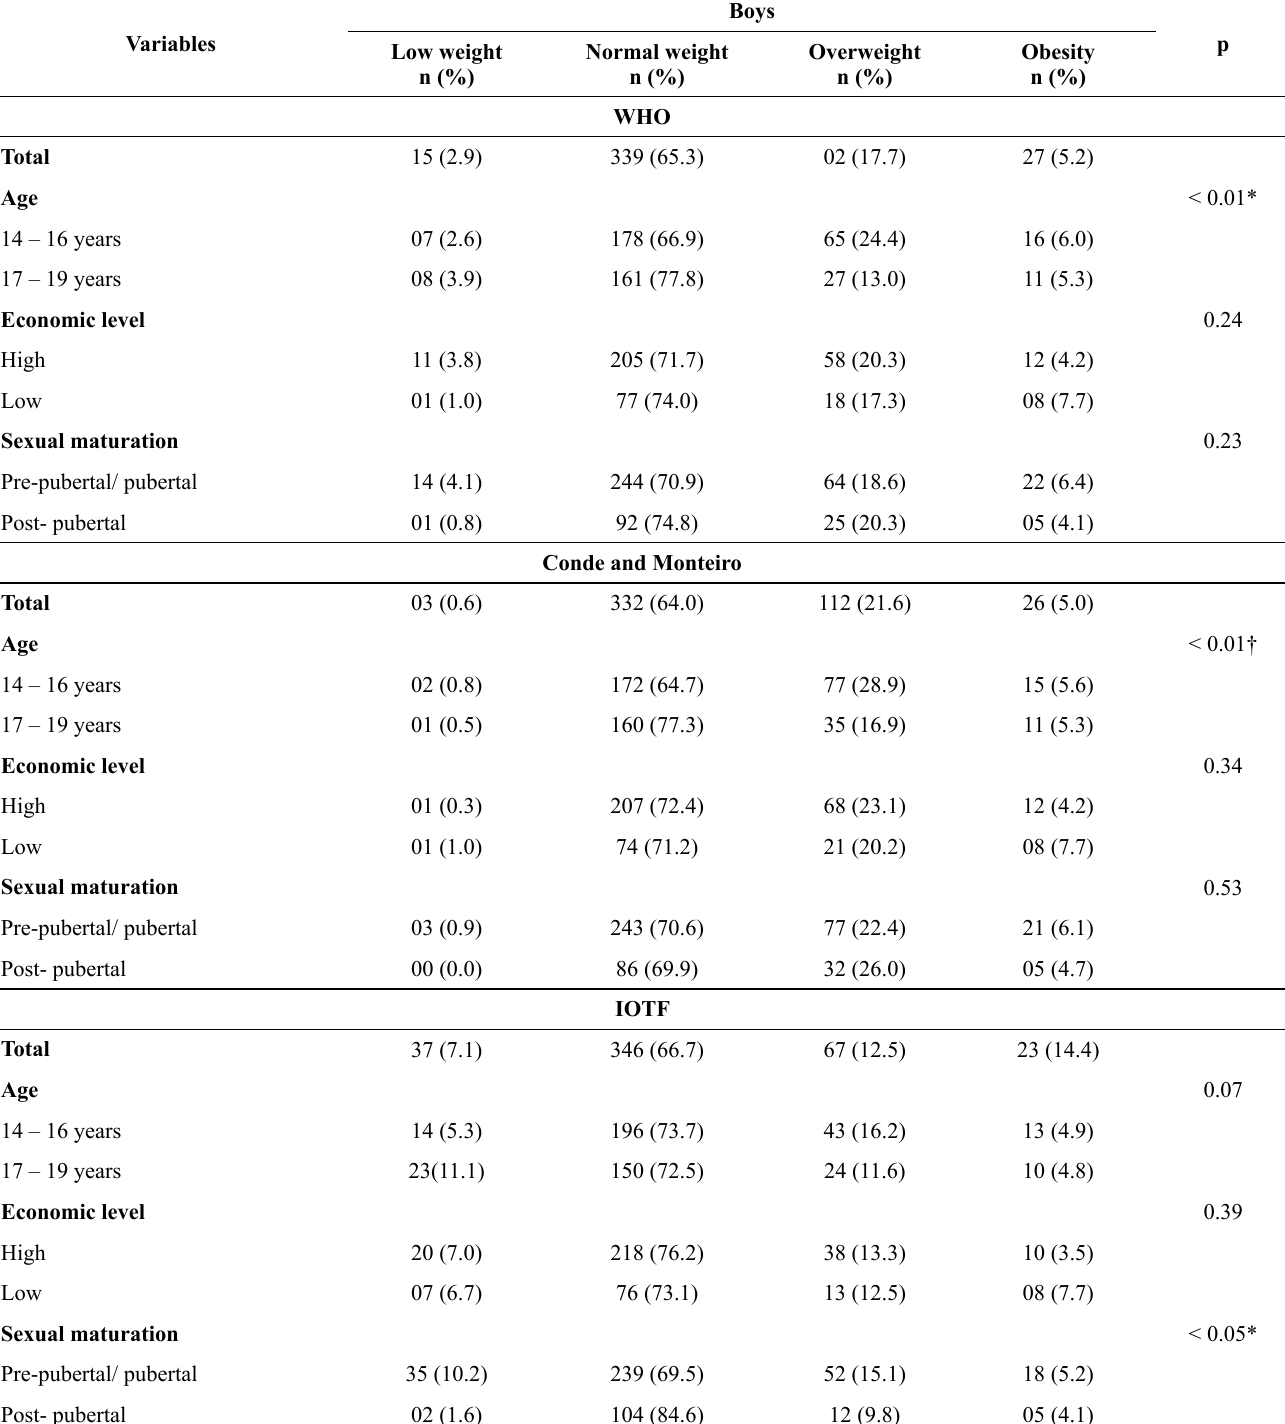
Table 1. Sample distribution in relation to sociodemographic factors associated with nutritional status classification according to three different criteria for boys (n =519, São José, Santa Catarina, Brazil Variables